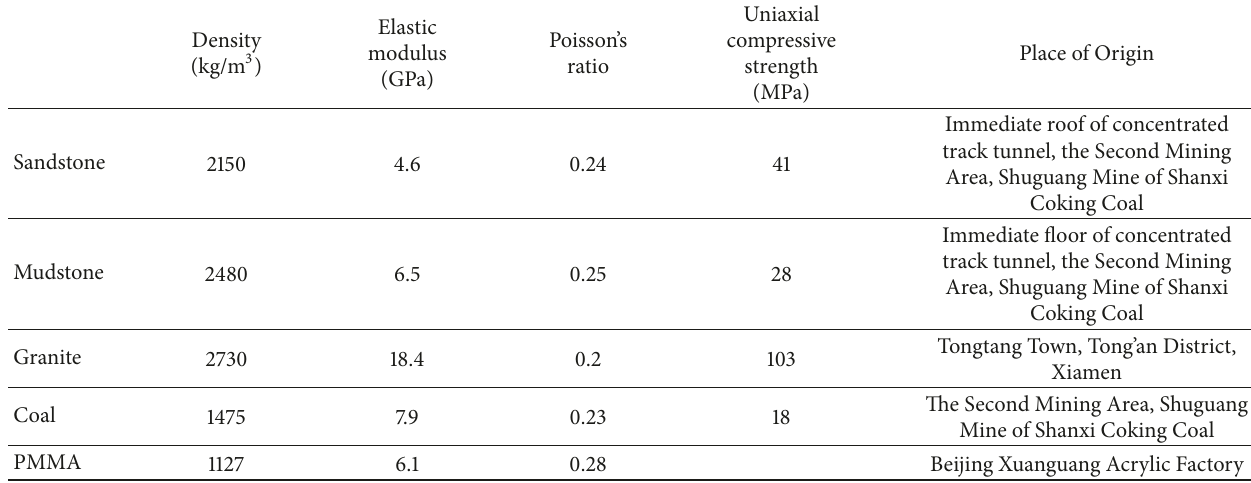
Table 1: Physical and mechanical parameters of typical rocks.